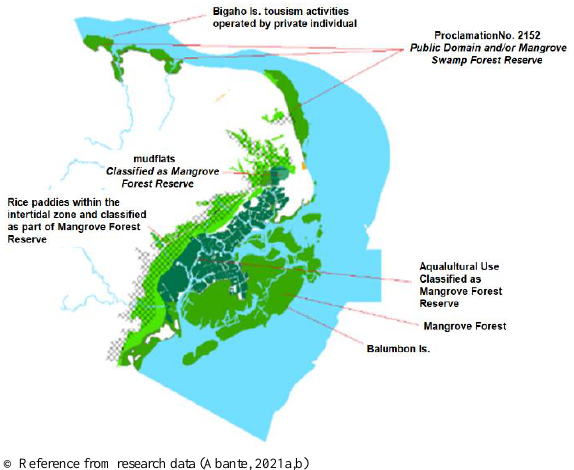
Figure 9 . Unplanned areas within the protection